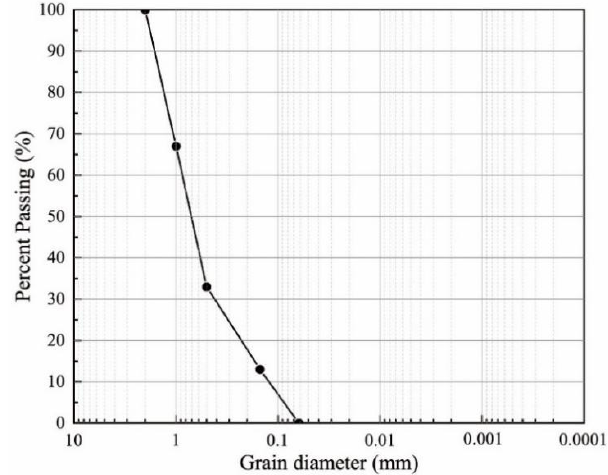
Figure 2. Grain size distribution